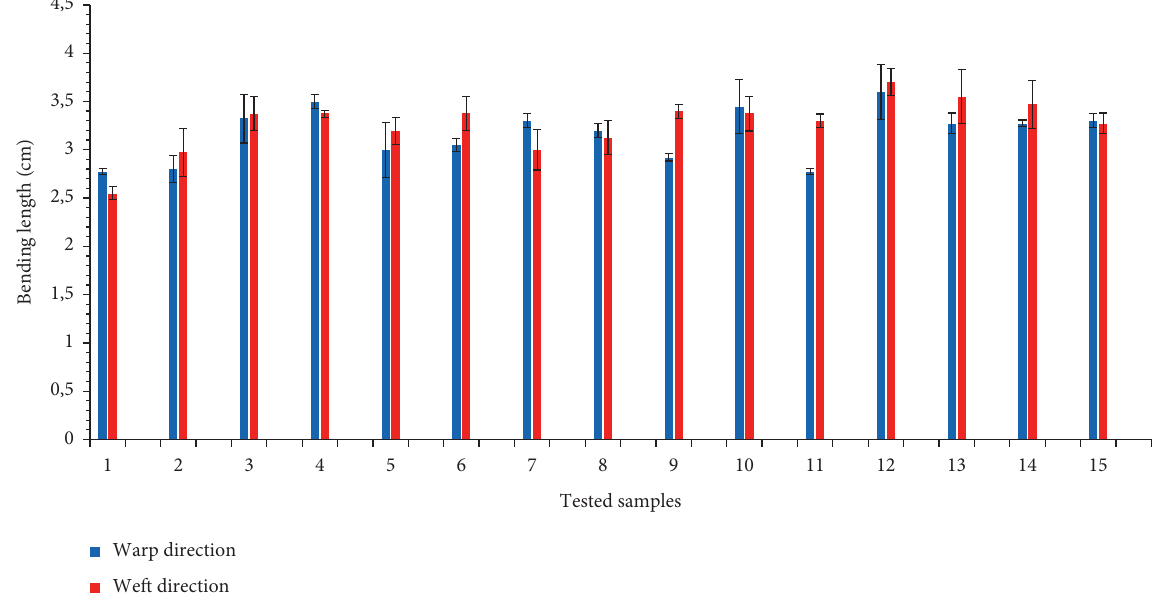
Figure 11: Bending length (cm) for coated samples measured according to warp and weft